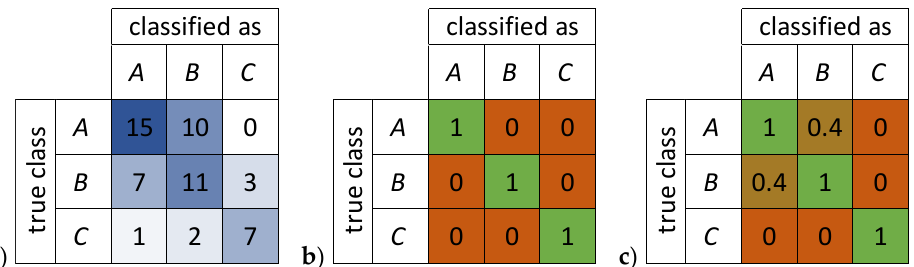
Figure 4. ( a ) Example of three-class confusion matrix; ( b ) metric implicitly used by the overall accuracy; ( c ) similarity metric used by the weighted accuracy.